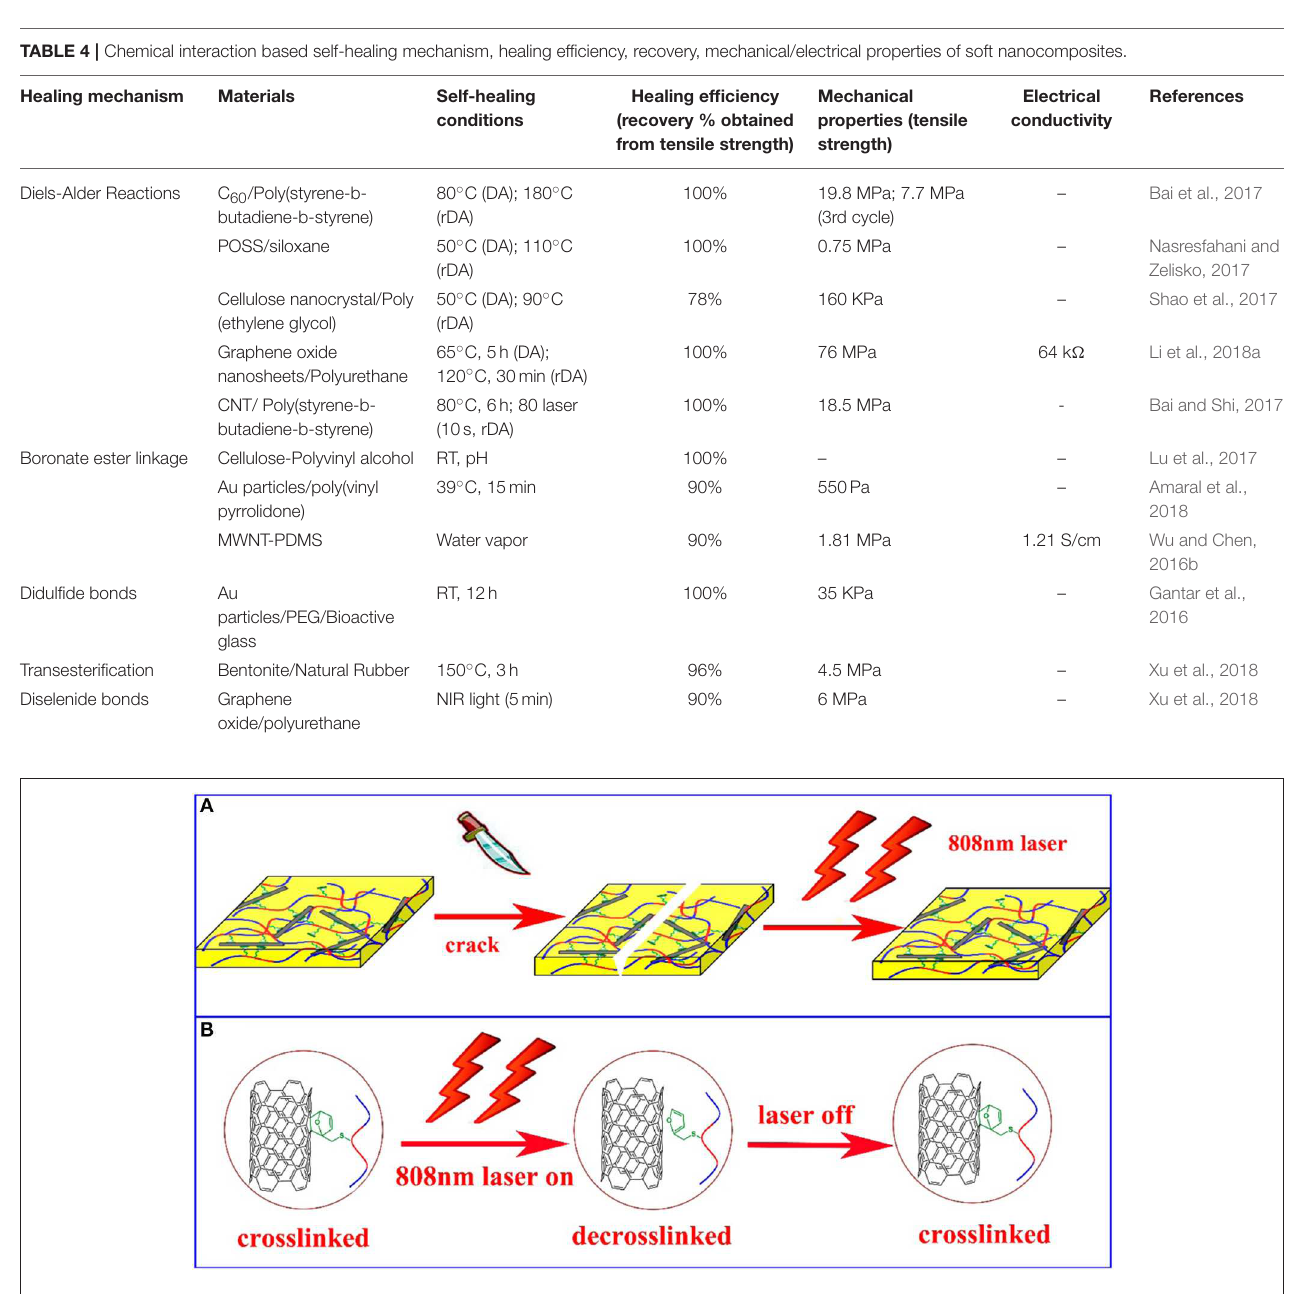
Frontiers in Materials |